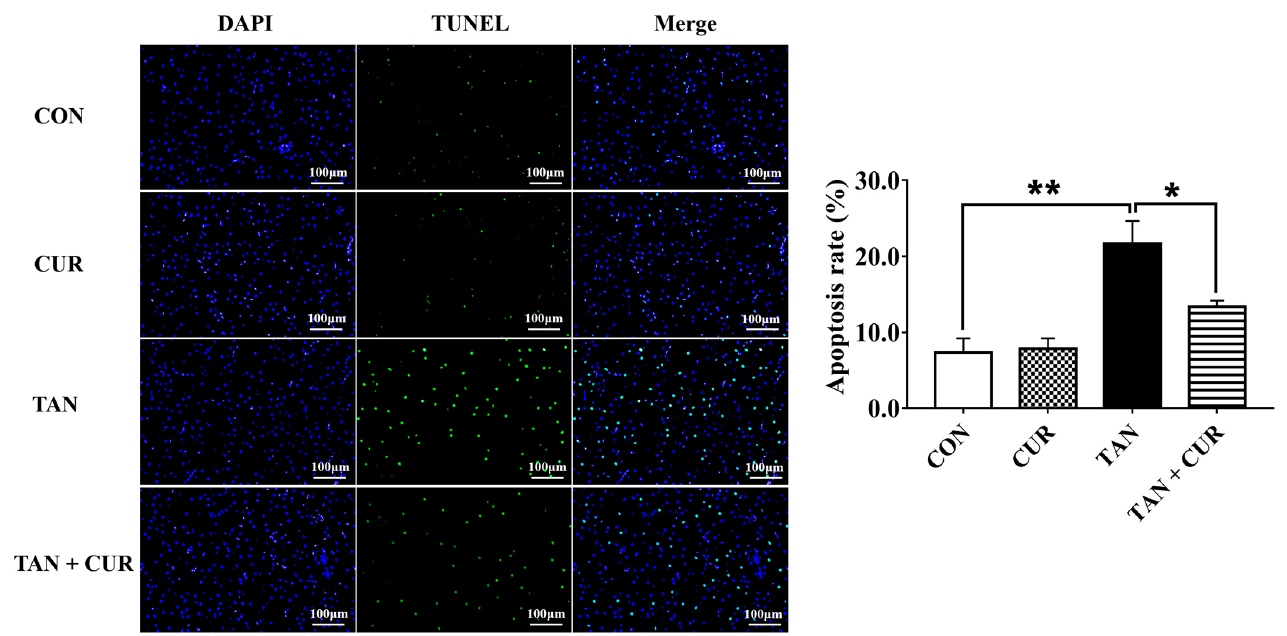
Figure 6. The results of terminal deoxynucleotidyl transferase dUTP nick-end labeling (TUNEL) staining in the normal and acute ammonia-stressed groups of gibel carp after eight weeks of feeding CUR diet. Under the fluorescence microscope, the apoptotic cells fluoresce in green, while the blue color represents the nucleus. Scale bar = 100 µm. The values are expressed as the mean ± standard error ( n = 6). * p < 0.05; ** p < 0.01.